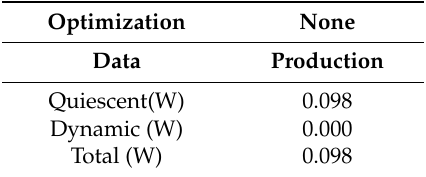
Table 3. Power summary of the proposal hardware.